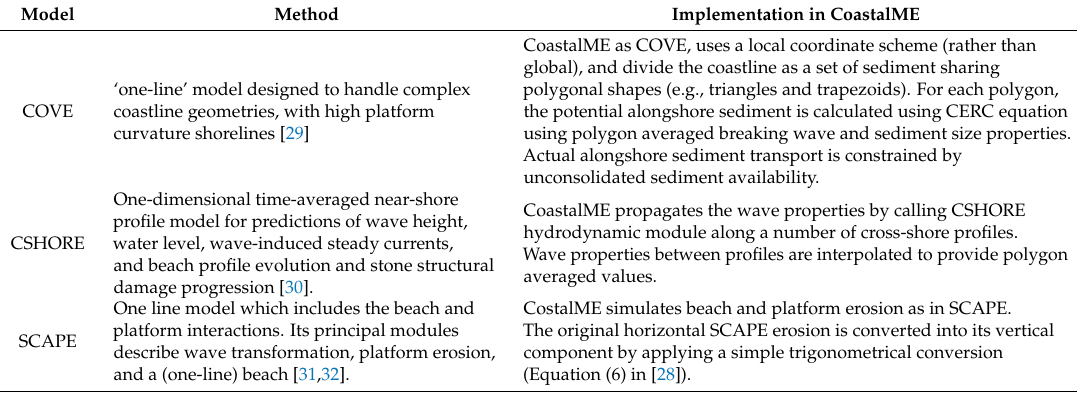
Table 1. Component model, description and what element is implemented in